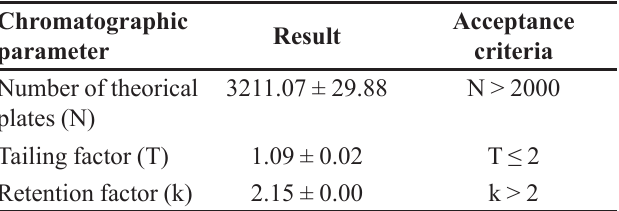
TABLE I - System suitability of the HPLC method